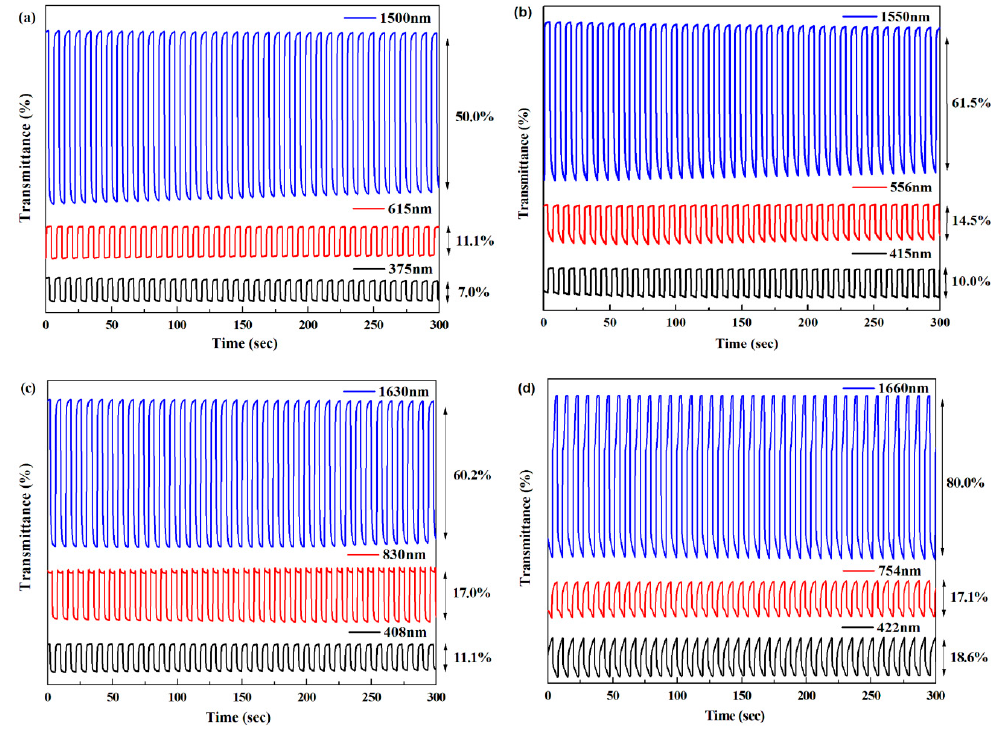
Figure 10. Transmittance change of the polymers with a same residence time of 4 s: ( a ) P1 monitored at 375, 615 and 1500 nm; ( b ) P2 monitored at 415, 556 and 1550 nm; ( c ) P3 monitored at 408, 830 and 1630 nm; and ( d ) P4 monitored at 422, 754 and 1660 nm.